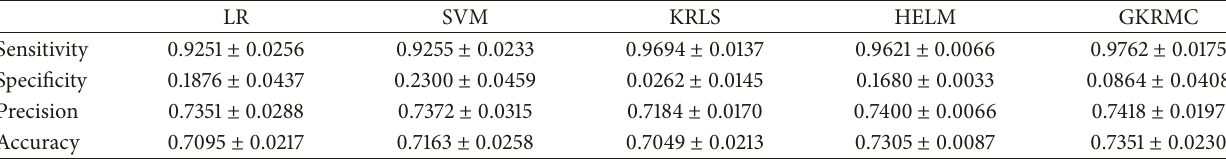
Table 8: The mutually explored